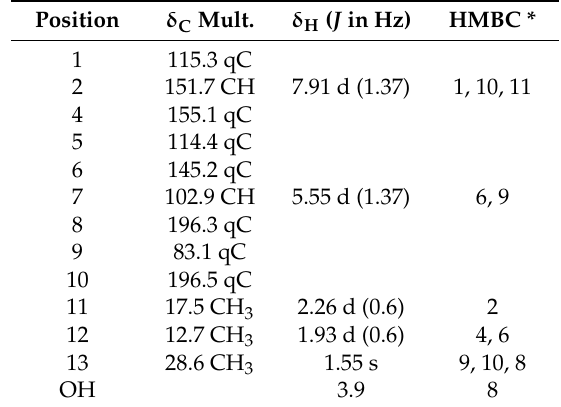
Table 2. 1 H and 13 C NMR spectral data of chlamyphilone (in CDCl 3 ). Position δ C Mult. δ H ( J in Hz) HMBC * 1 115.3